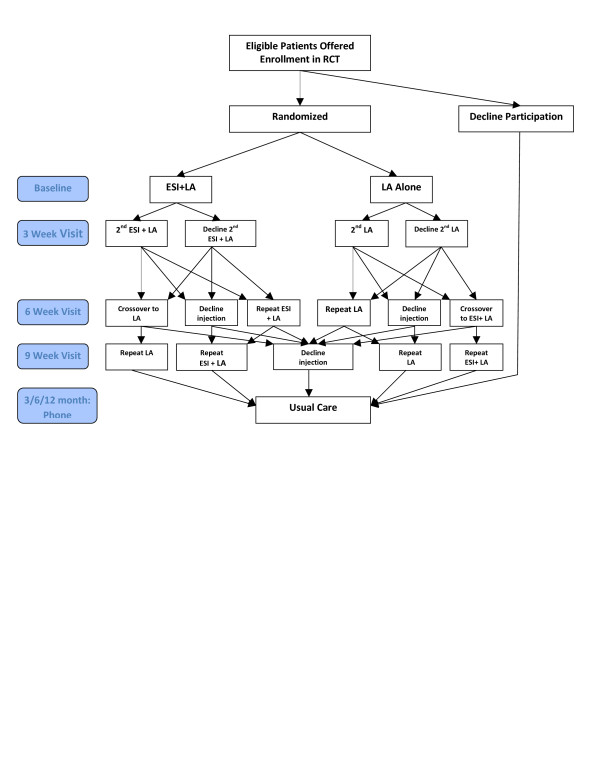
Study Flow Chart.